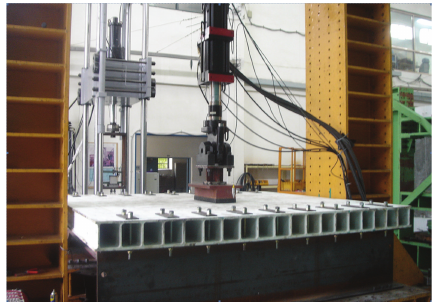
Figure 4: Fatigue testing with FRP deck.